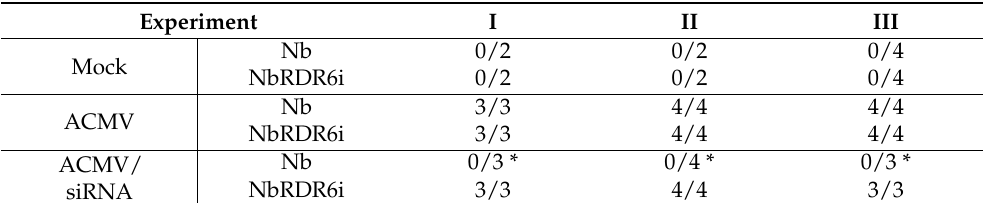
Table 3. Hotspot siRNA-mediated antiviral protection requires RDR6